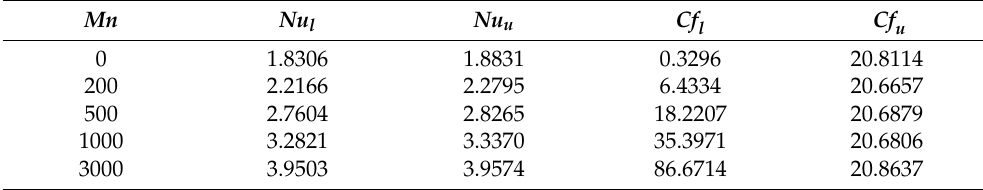
Table 6. Impact of the magnetic interaction parameter ( Mn ) on the physical